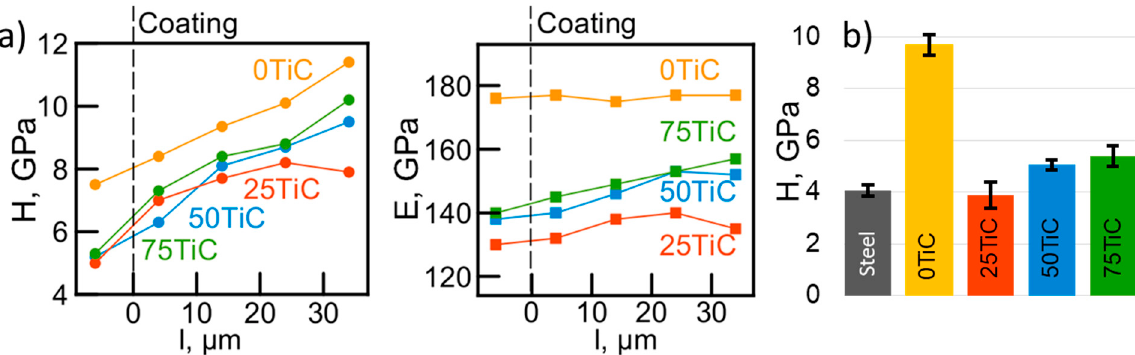
Figure 7. Results of nanoindentation (hardness, H, and elastic modulus, E) ( a ) and microhardness measurements ( b ).